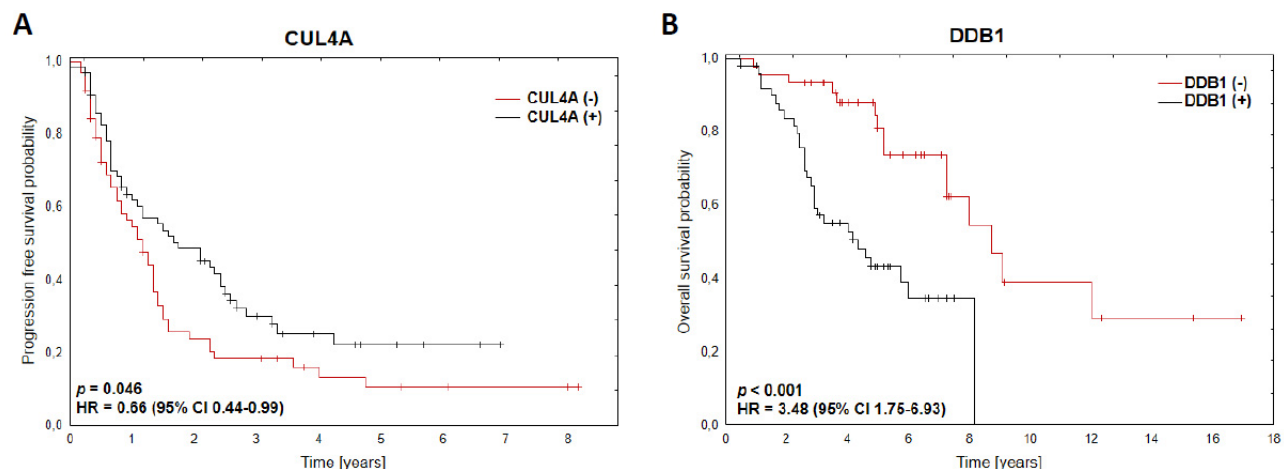
Figure 1. ( A ) Kaplan–Meier survival curves for PFS according to CUL4A expression (classified as positive and negative results of IHC staining), n = 130. ( B ) Kaplan–Meier survival curves for OS according to DDB1 expression (classified as positive and negative results of IHC staining), n = 97.